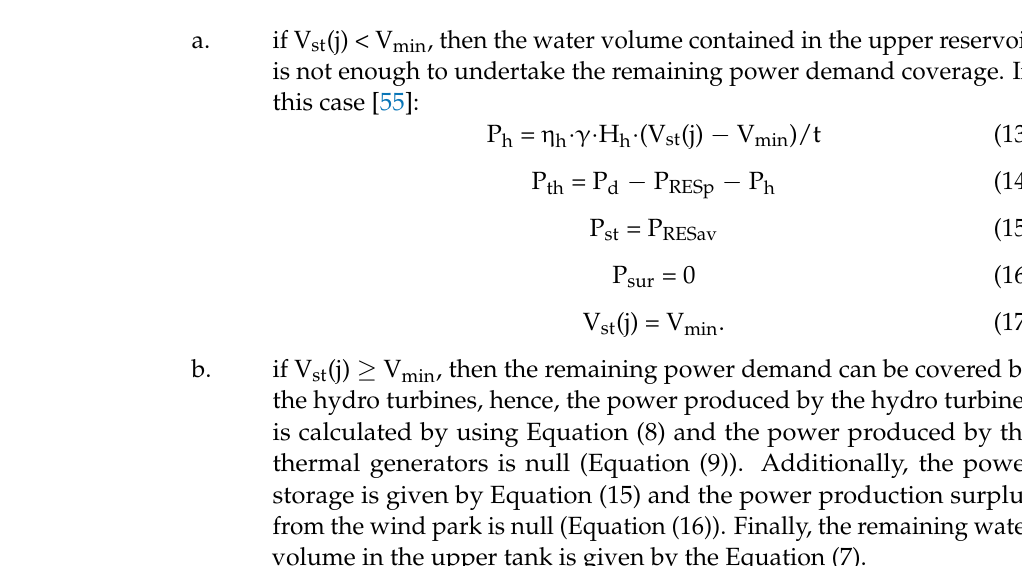
Figure 6. Final annual power demand time series with the introduction of the EV charging load. The wind potential at the wind park’s installation site was evaluated with certified wind potential measurements accomplished over a period of 14 months, from July 2016 to September 2017, covering the summer months twice, namely the crucial peak demand period. The average wind velocity during the measurement period was 9.89 m/s, classify- ing the available wind potential among the highest in Europe [59]. Most importantly, dur- ing July and August, namely during the peak demand period, the average monthly wind velocity was measured at 11.8 and 9.1 m/s, respectively, in 2016, and at 10.1 and 12.0 m/s, respectively, in 2017, revealing concurrency between the availability of high wind poten- tial and the peak demand period. In Figure 7, the wind rose and the wind velocity Weibull distribution (C = 11.2 m/s, k = 1.91) are presented, based on the available measurements [60]. Another important feature revealed from the wind rose graph is the almost constant wind blowing direction from the north-northeast, perpendicular to the mountain’s ridge orientation. This feature, apart from the minimization of the wake shading losses, is ex- pected to provide an important contribution to the insular grid’s stability, due to the sta- ble, scarcely fluctuating northerly winds, enabling the more secure and constant produc- tion of the wind turbines.